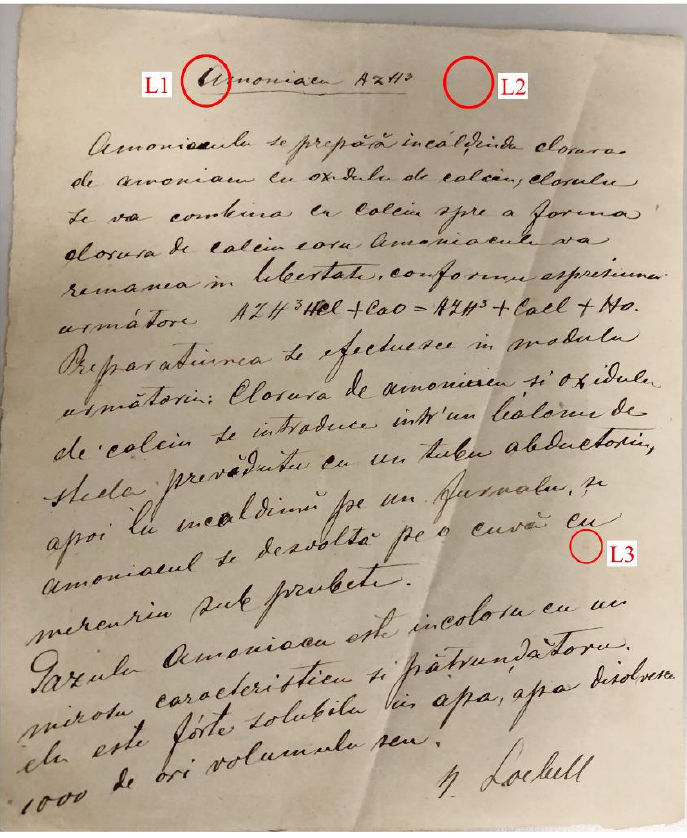
Figure 1. Student Loebell’s chemistry test—S1 and the analyzed areas (L1, L2 and L3) .